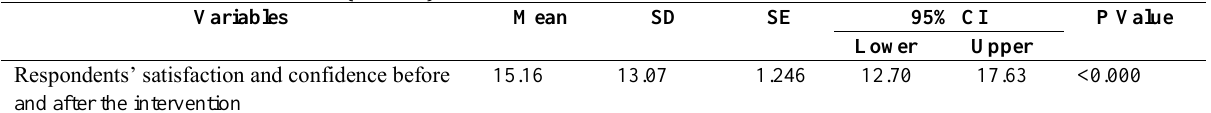
Table 4. The effect of providing Online Clinical Learning M ethods with “thinking like a nurse” Method on S tudents’ Satisfaction and Self-confidence (N=110)